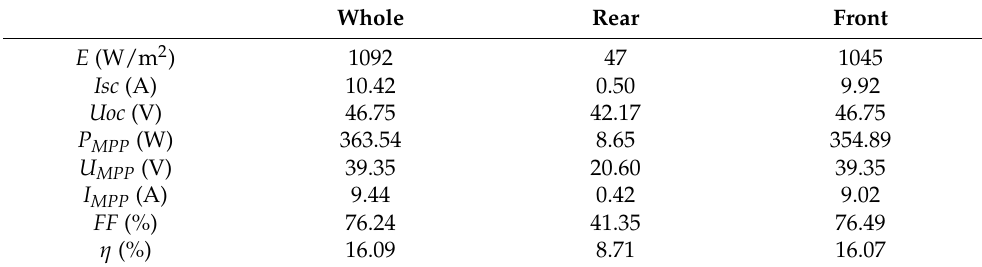
Table 15. The measurements results and calculations for 60 ◦ inclination of the module over the grass substrate, considering the values for the whole-module generation and its rear side